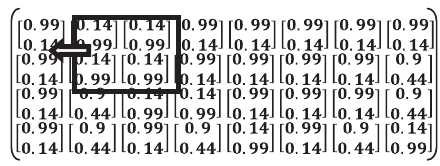
Figure 11. Mutation Operators: Bloc of Qubit Mutation.